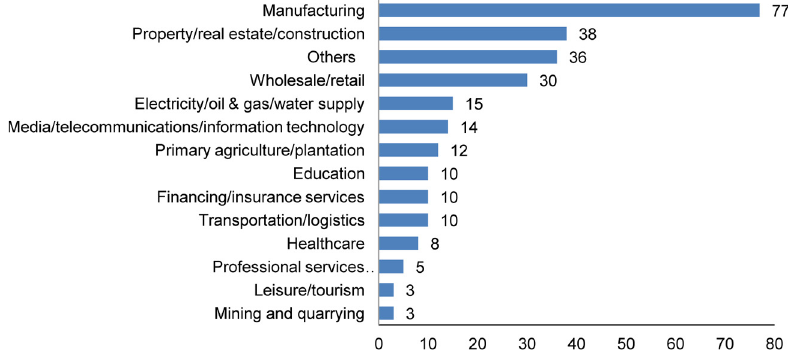
Figure 4. Ranking of